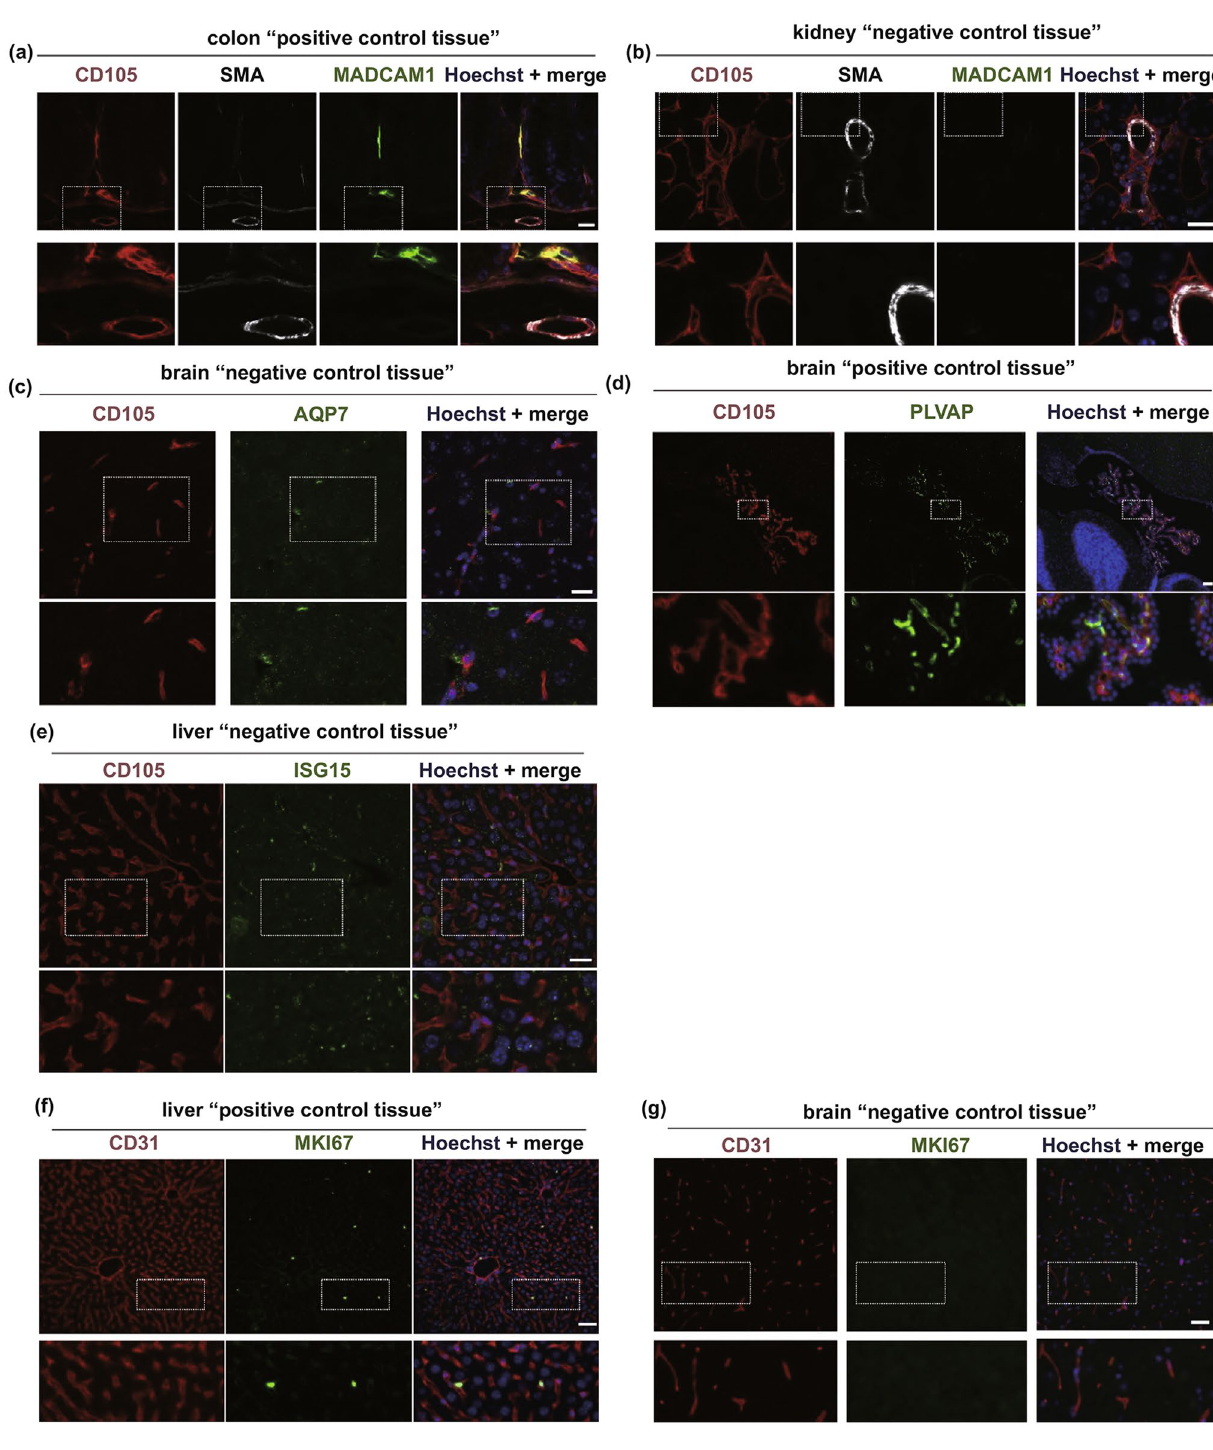
Fig. 8 Protein validation of specialized endothelial cells phenotypes. a , b Representative micrographs of mouse colon. c , d Representative micrographs of mouse brain sections (negative and positive control group). e–g Representative micrographs of mouse liver (negative and posi- tive control groups)